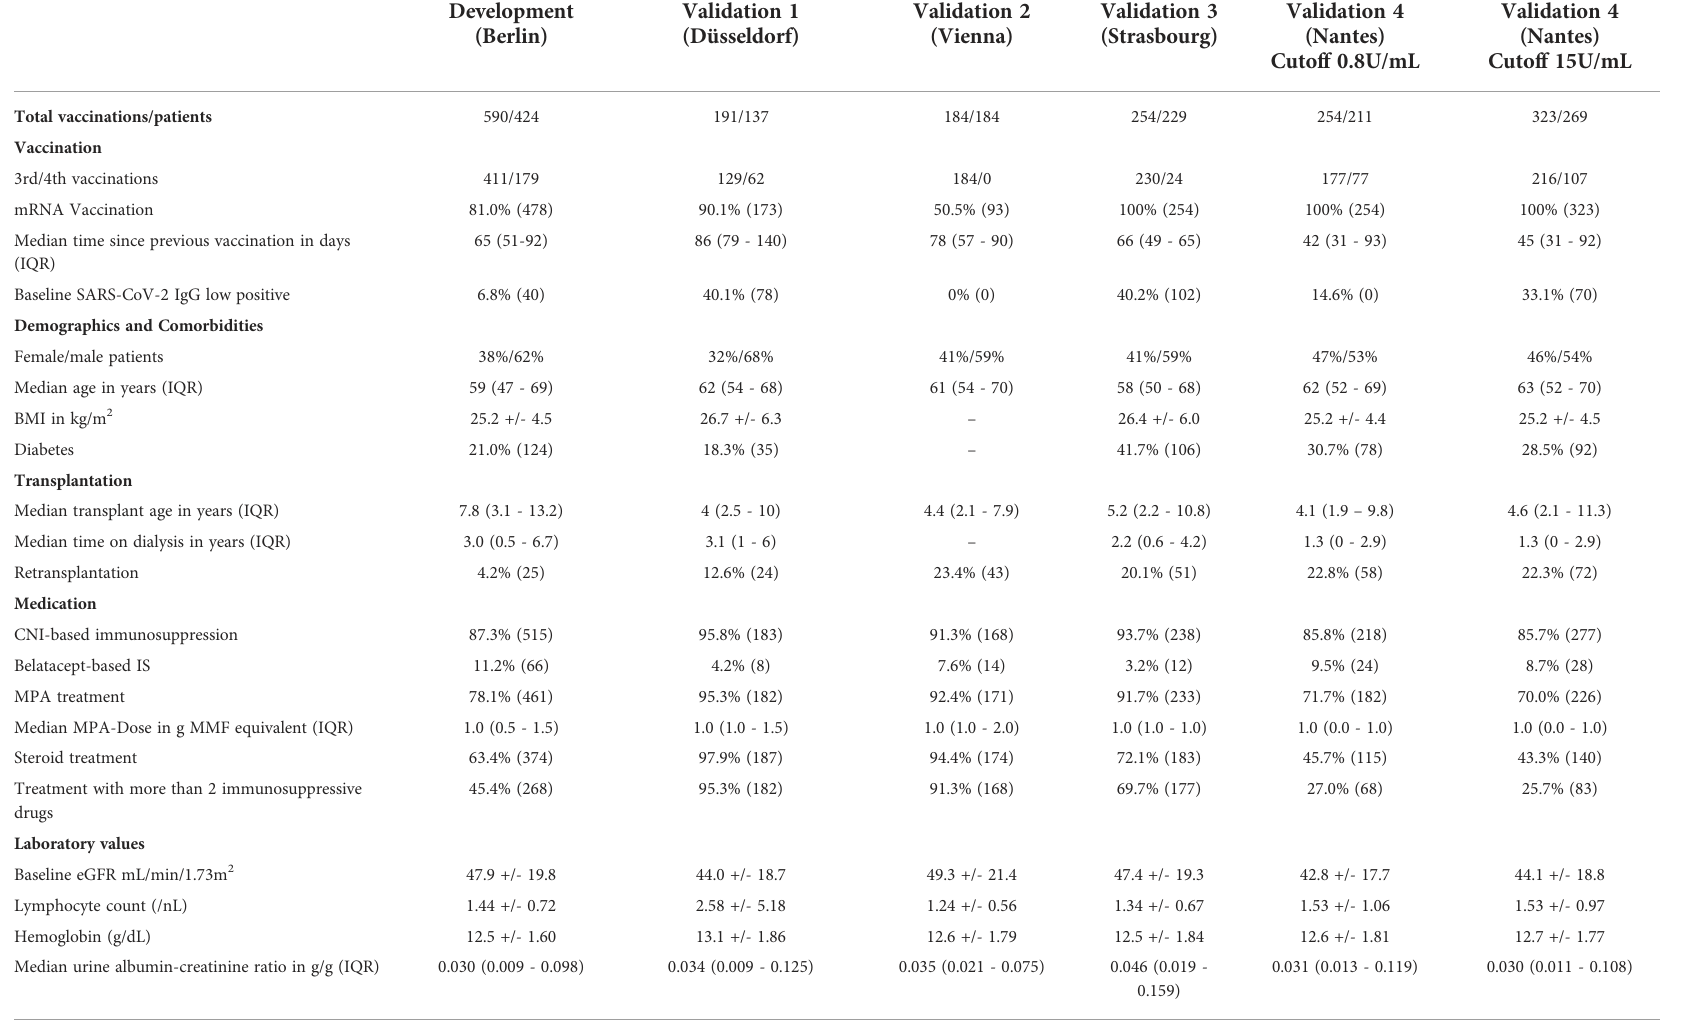
TABLE 3 Baseline characteristics of the development and validation